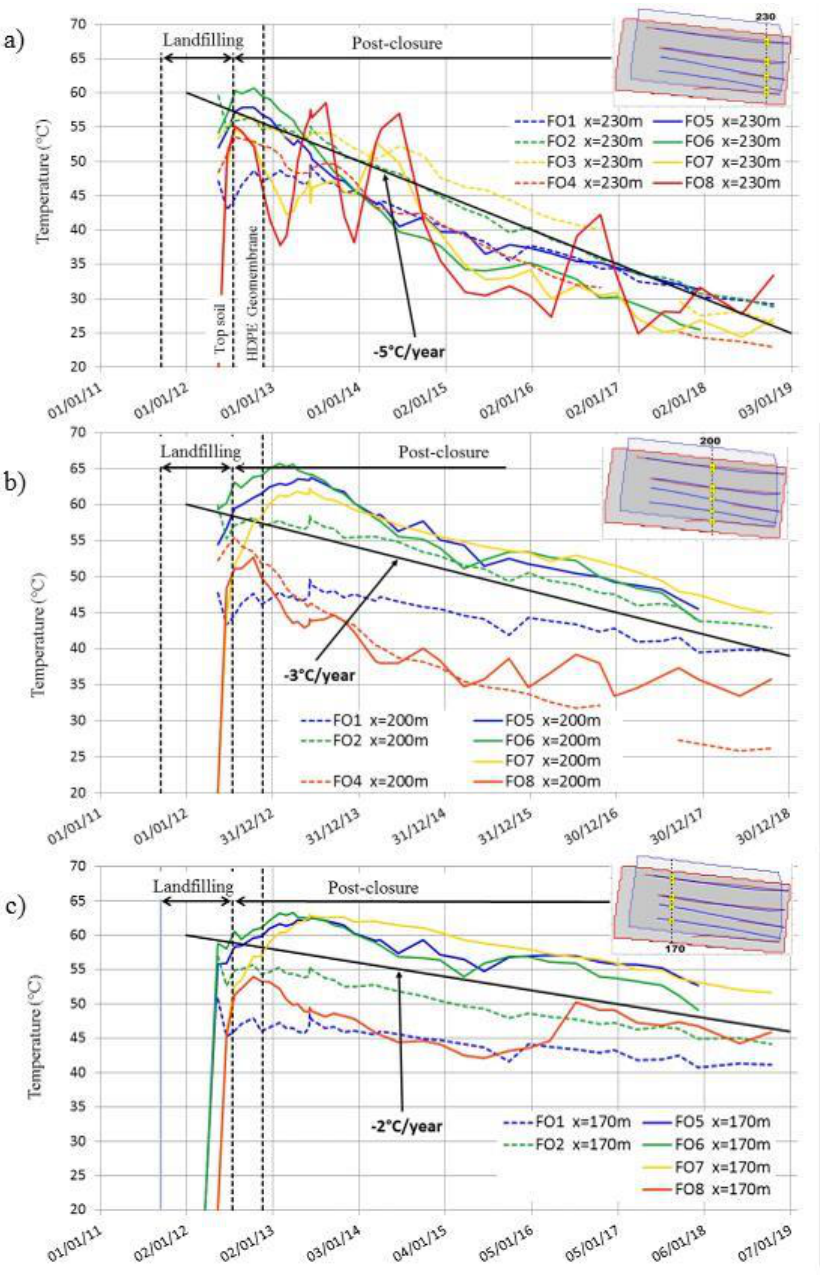
Figure 8. Evolution of specific measurement points from optical fibres lines: ( a ) x = 230 m, ( b ) x = 200 m and ( c ) x = 170 m.